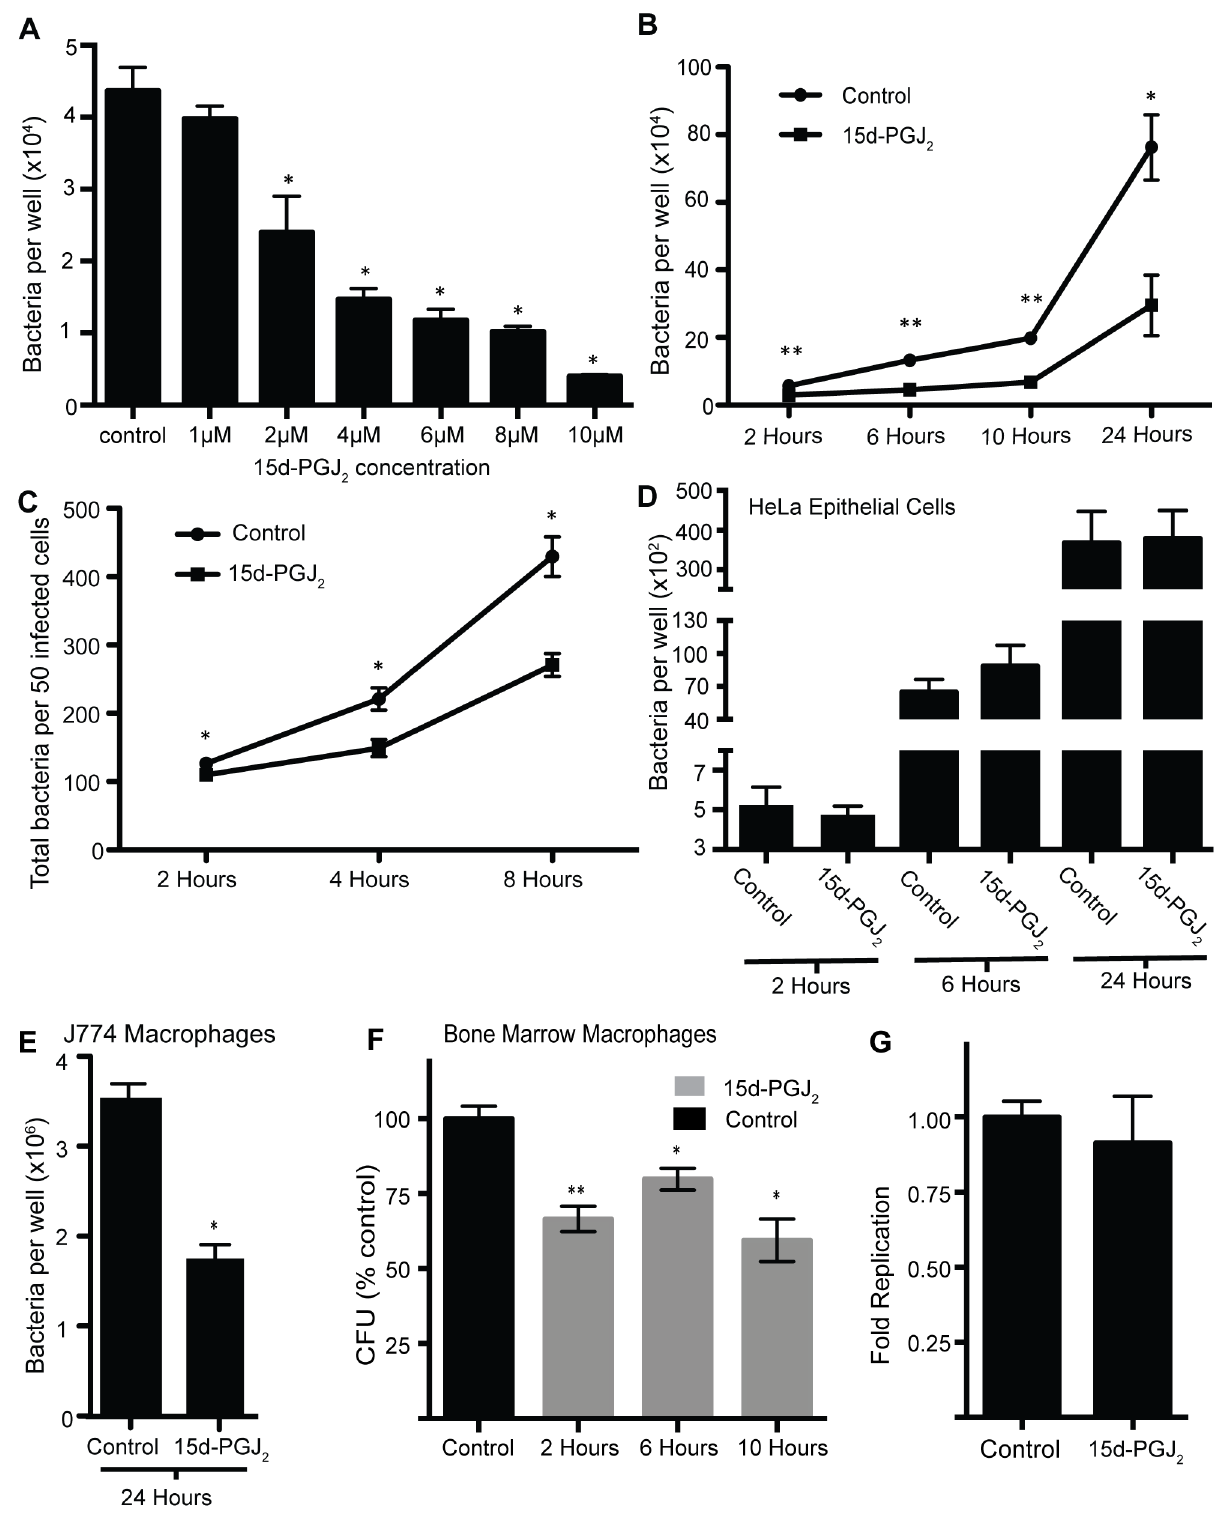
Figure 3. Salmonella colonization of macrophages is significantly reduced by the addition of 15d-PGJ 2 . ( A ) Salmonella colonization of RAW264.7 macrophages with the addition of increasing concentrations of 15d-PGJ 2 at 24 hours post infection. ( B ) The effect of 2 m M 15d-PGJ 2 on Salmonella colonization of RAW264.7 macrophages over time as determined by CFU analysis. ( C ) Immunofluorescence microscopy was used to enumerate bacterial colonization in individual macrophages at 2, 4 and 8 hours post-infection. ( D ) Salmonella colonization of HeLa epithelial cells treated with 15d-PGJ 2 at 2, 6, and 24 hours post-infection. ( E ) The effect of 15d-PGJ 2 on Salmonella colonization of J774 macrophages cells, as determined by CFU analysis at 24 hours. ( F ) Salmonella colonization of bone marrow macrophages at 2, 6, and 10 hours post-infection, with 15d-PGJ 2